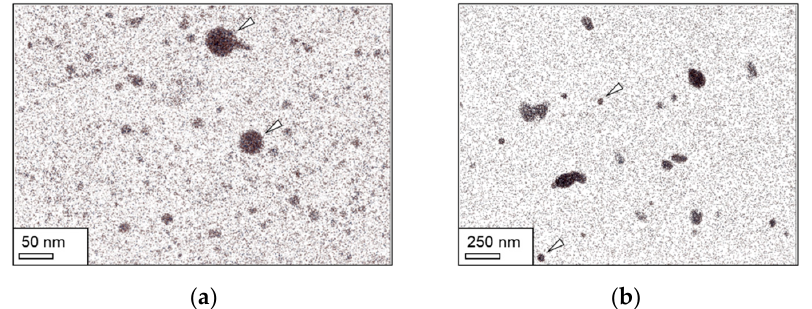
Figure 7. Maps of the combined Y and Ti EDS signal showing the larger dispersoids found in material near the weld line ( a ) and from an outer expulsion region ( b ) of a joint produced using Weld Condition 1 (contrast has been inverted for improved visibility, with strong signal points appearing dark and weaker points appearing light). Note the difference in scales and the enlargement and roughening of particles shown in ( b ). Arrows have been added to highlight similar sized dispersoids in each scan.